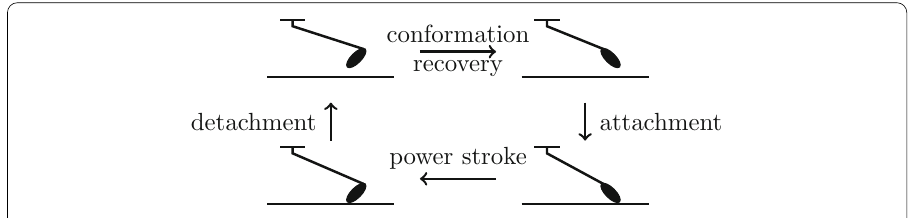
Fig. 1 Lymn–Taylor cycle representation. Each stage of the cycle can be seen as a change of chemical